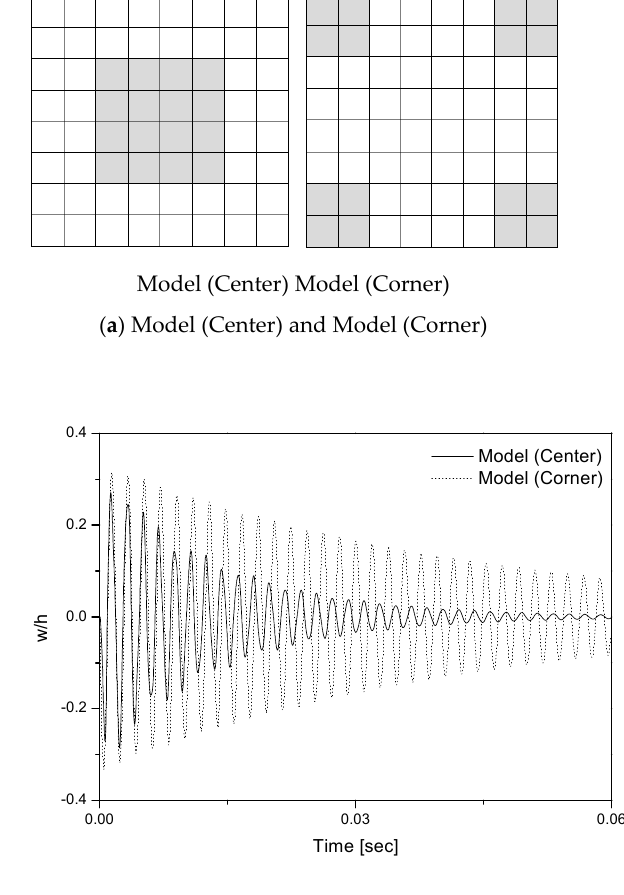
Figure 5. Non-dimensional deflections according to various locations for sensor/actuator pairs.